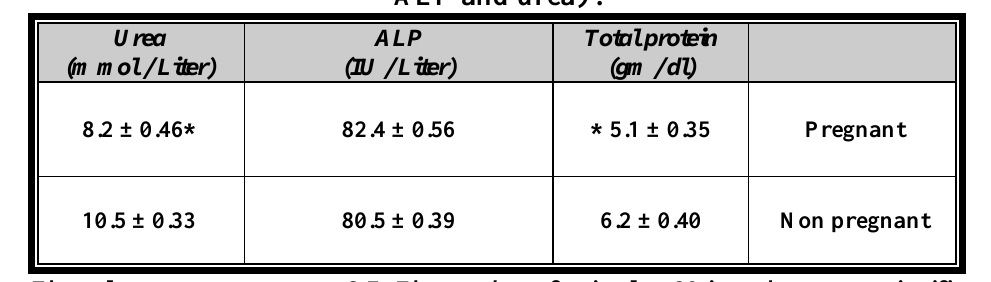
- The values represent mean ± S.E, The number of animals = 30 in each group, * significantly different (P